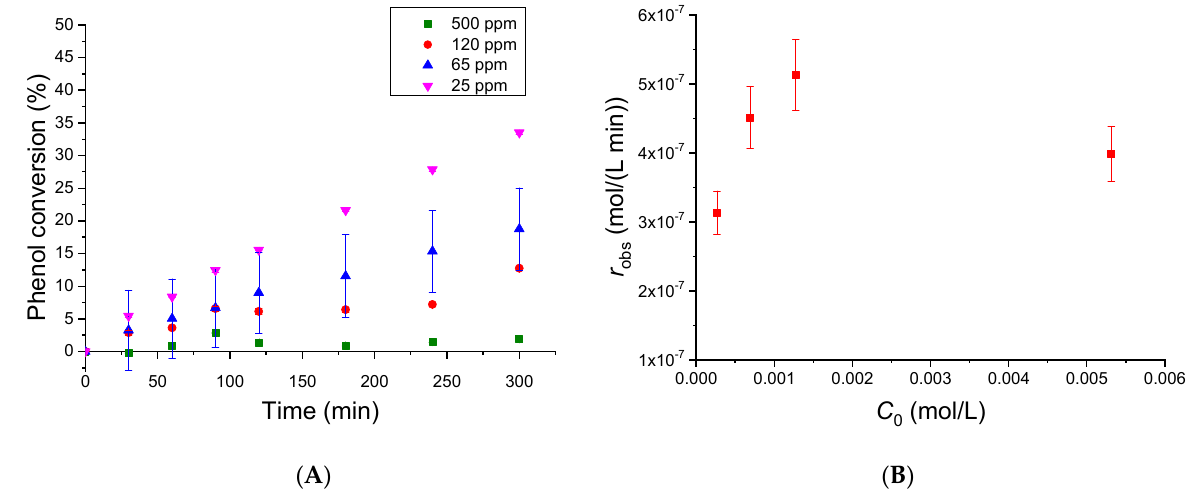
Figure 5. Effect of the initial phenol concentration on: ( A ) the phenol conversion; ( B ) the observed reaction rate ( r obs ), fi xing T = 40 °C and a catalyst loading of 0.50 g/L.